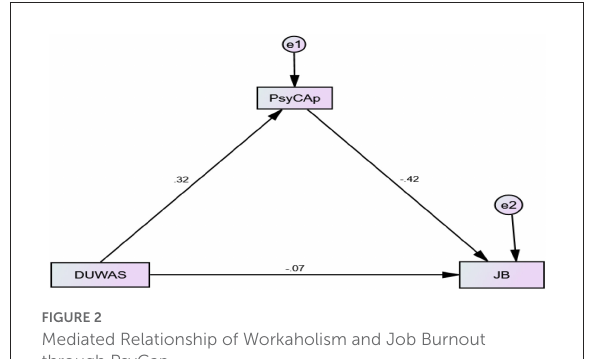
FIGURE2 Mediated Relationship of Workaholism and Job Burnout through